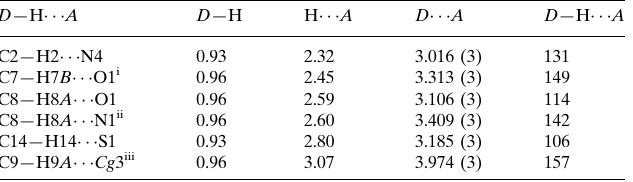
Hydrogen-bond geometry (A˚ , (cid:1)